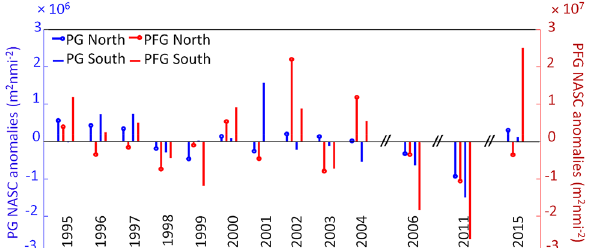
Figure 5. Anomaly of the pelagic mean pelagic abundance (expressed as Nautical Area Scattering Coefficient ‘NASC’, m 2 nmi −2 ) for the plankton group (PG) and pelagic fish group (PFG) in the areas north and south of Cap Blanc.